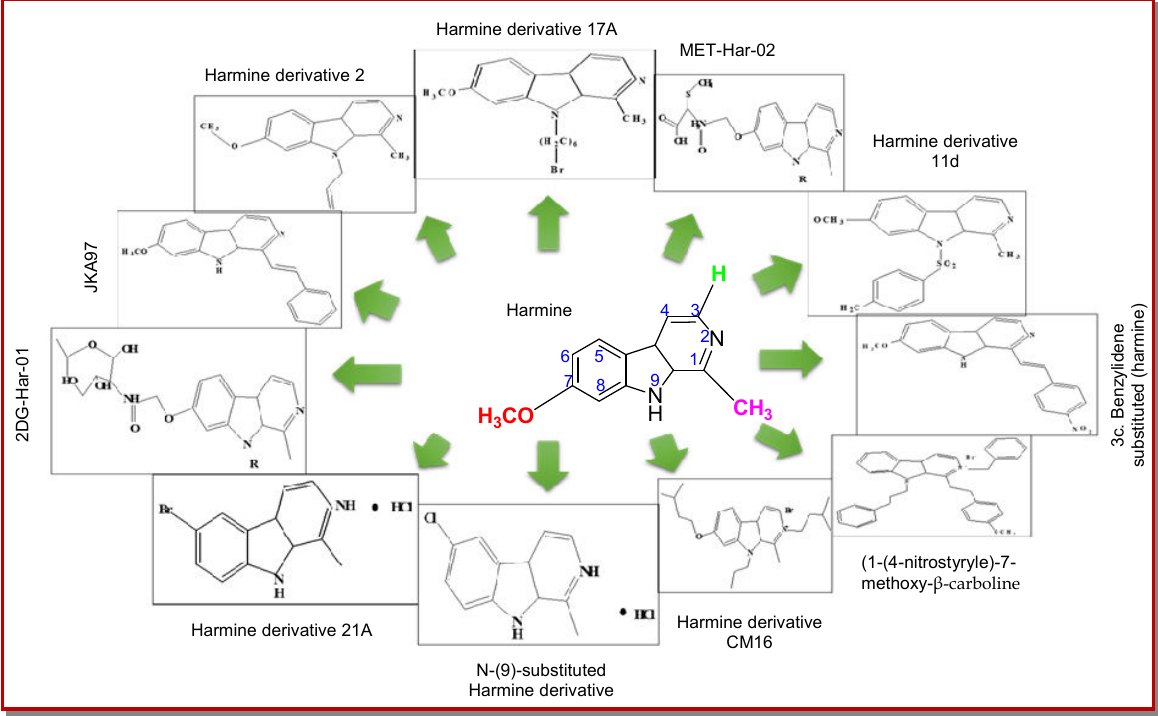
Figure 1: Hermine and its